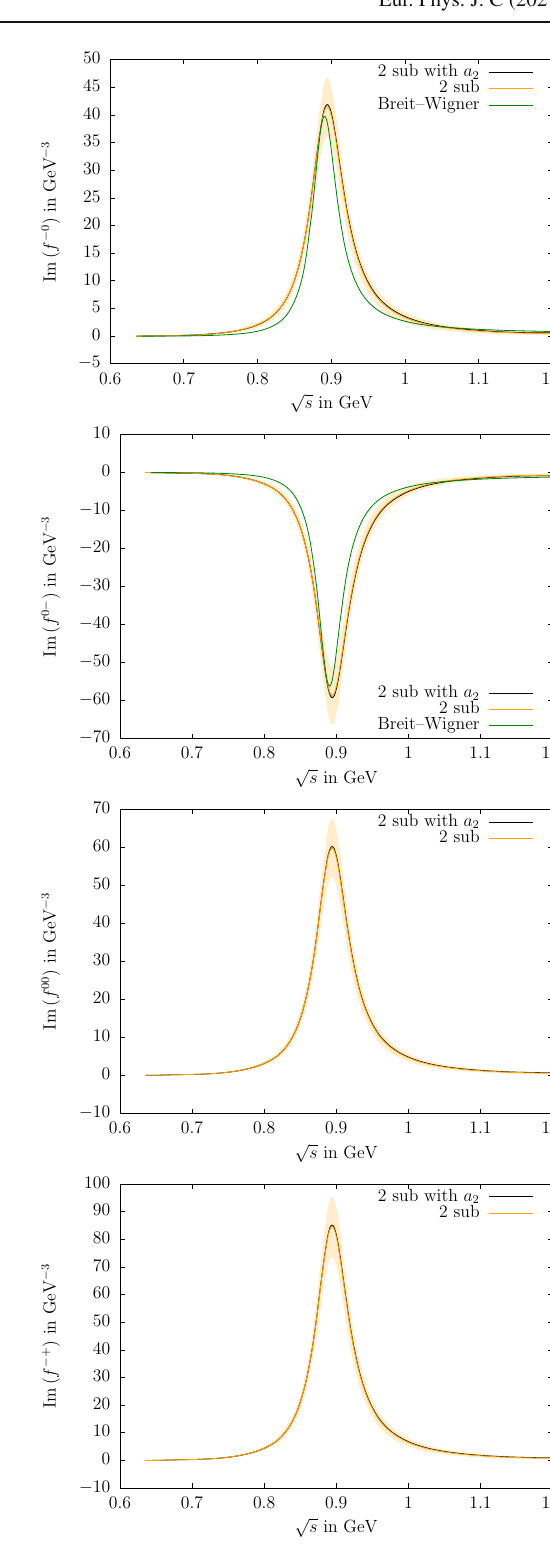
real and imagnary parts of the partial waves, respectively. For compari- son a Breit–Wigner model [44] is also shown. For the solution without the a 2 resonance, the error bands refer to the uncertainties on the sub- traction constants and the t -channel